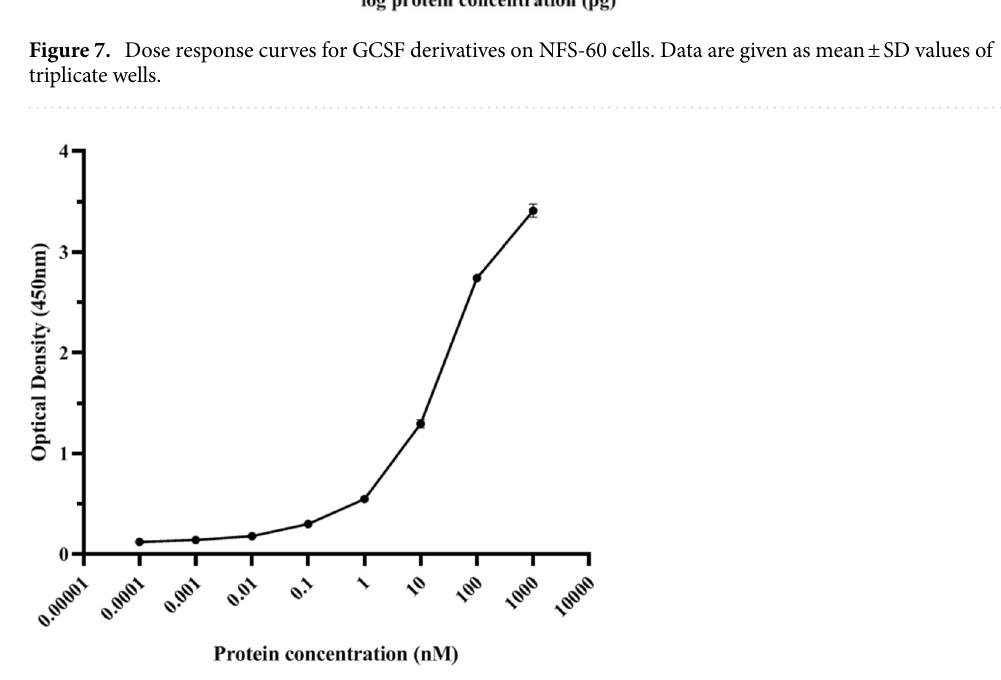
Figure 8. ELISA showing HSA binding of ABD-GCSF. The graph represents the mean ± SD of